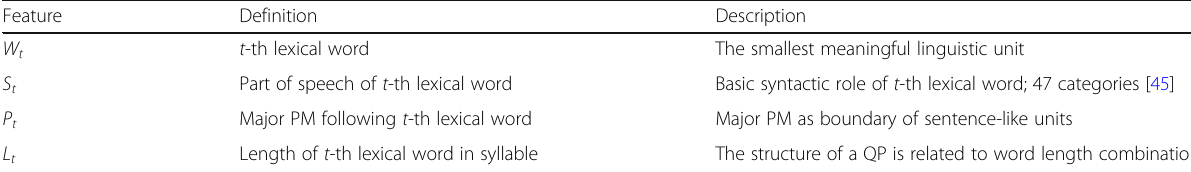
Table 12 Significance of the linguistic features Feature